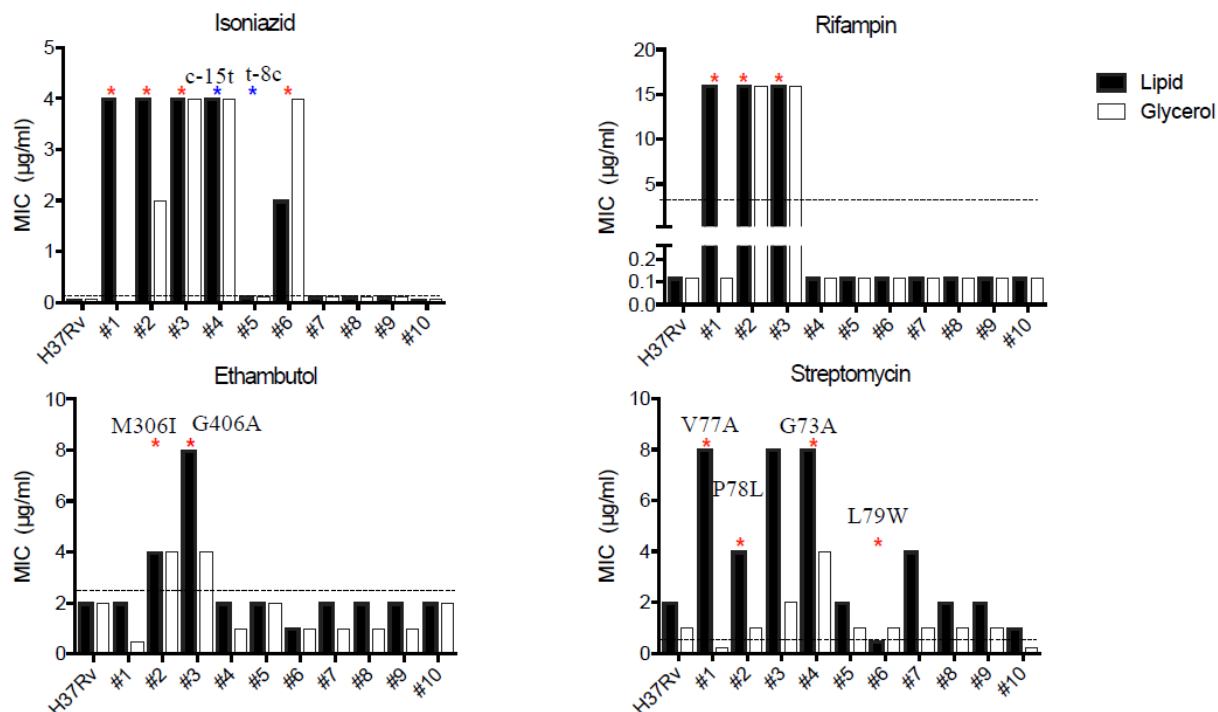
Figure 3. MIC results of lipid-grown strains. MIC assay performed in lipid medium (black bars) and glycerol-rich medium (white bars). * indicates presence of drug-associated mutations, as follows: INH katG[S315T] (red), fabG1 (blue; details depicted in figure); RIF rpoB[S450L]; EMB embB; SM gidB (amino acid substitutions depicted in figure). Dashed line shows WHO critical concentration in 7H9. EMB: ethambutol; INH: isoniazid; MIC: minimal inhibitory concentration; RIF: rifampin; SM: streptomycin.